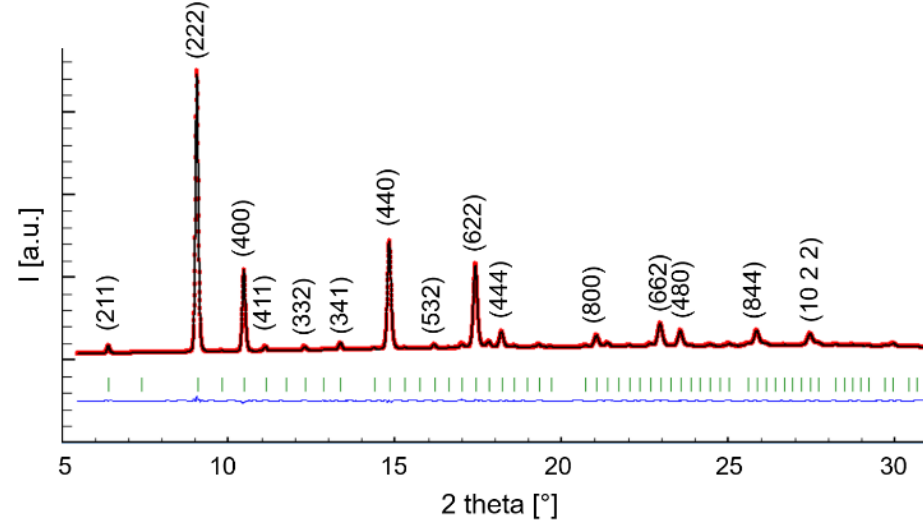
Figure 5. Rietveld refinement plot of sample Sm60_4.11. The red and the black lines are the experimental and the calculated diffraction pattern, respectively; the blue line is the difference curve; vertical bars indicate the calculated positions of Bragg peaks.